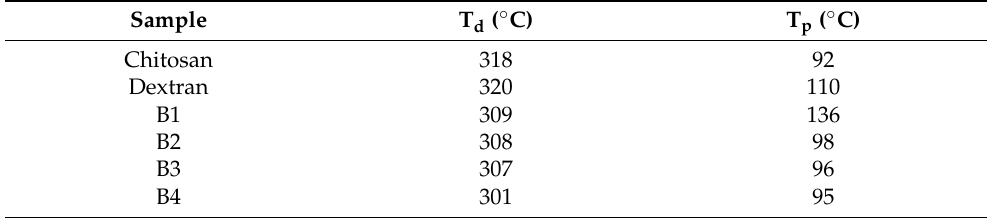
Table 3. Decomposition and peak transition temperatures of chitosan, dextran, and their nanocomposites.